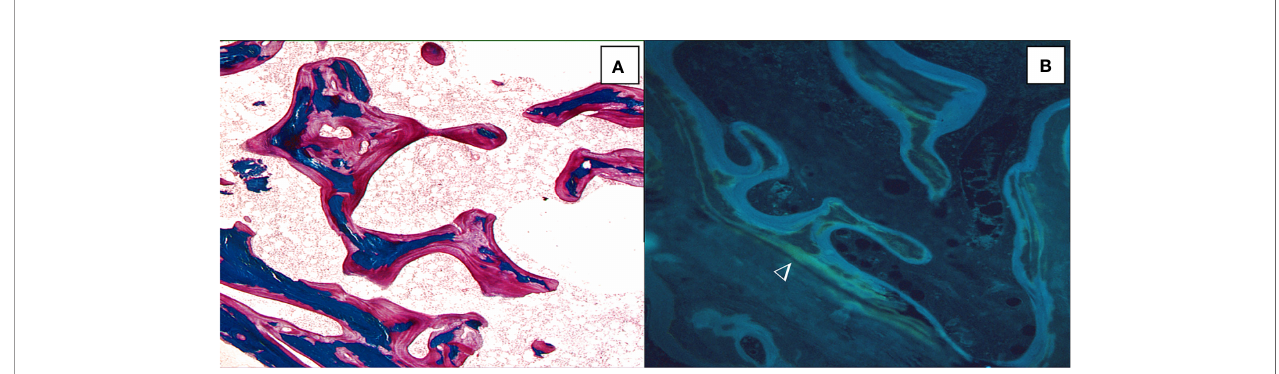
FIGURE 4 | Osteomalacia is characterized by thick and extended osteoid seams ( A , solochrome cyanin R, x100) and diffuse tetracycline labels ( ► ) ( B , unstained section under ultraviolet